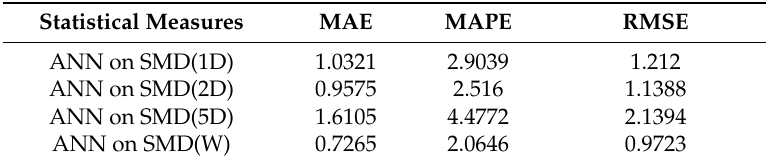
Table 3. Statistical measurement results of ANN on statistical data. Statistical Measures MAE MAPE